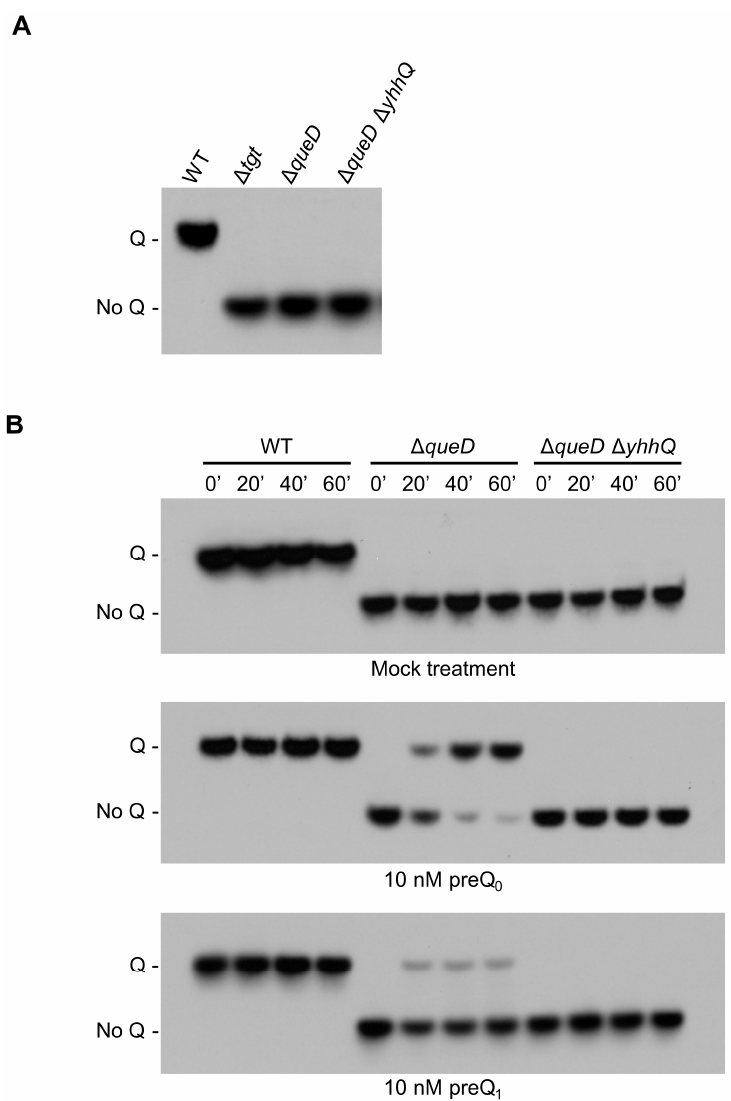
Figure 3. Detection of Q in tRNA Asp GUC as a representative of the salvage of the Q precursors preQ 0 and preQ 1 . E. coli bulk tRNAs were separated in an 8 M urea, 8% polyacrylamide gel containing 0.5% 3-(acrylamido)phenylboronic acid and then transferred to a nylon membrane. The transferred tRNAs were probed with a biotinylated primer, and visualized by chemiluminescence. ( A ) tRNAs modified with Q migrate slower than unmodified tRNA, as illustrated with tRNA from Wild Type (WT), and ∆ tgt grown in Luria-Bertani (LB - positive and negative control, respectively). tRNAs from ∆ queD and ∆ queD ∆ yhhQ grown in defined minimal medium M9 + 0.5% glycerol do not have Q; ( B ) test of the salvage capability of the WT (positive control for Q detection), ∆ queD and ∆ queD ∆ yhhQ strains towards mock (negative control), 10 nM preQ 0 and 10 nM preQ 1 treatments. Representative Northern blots shown.